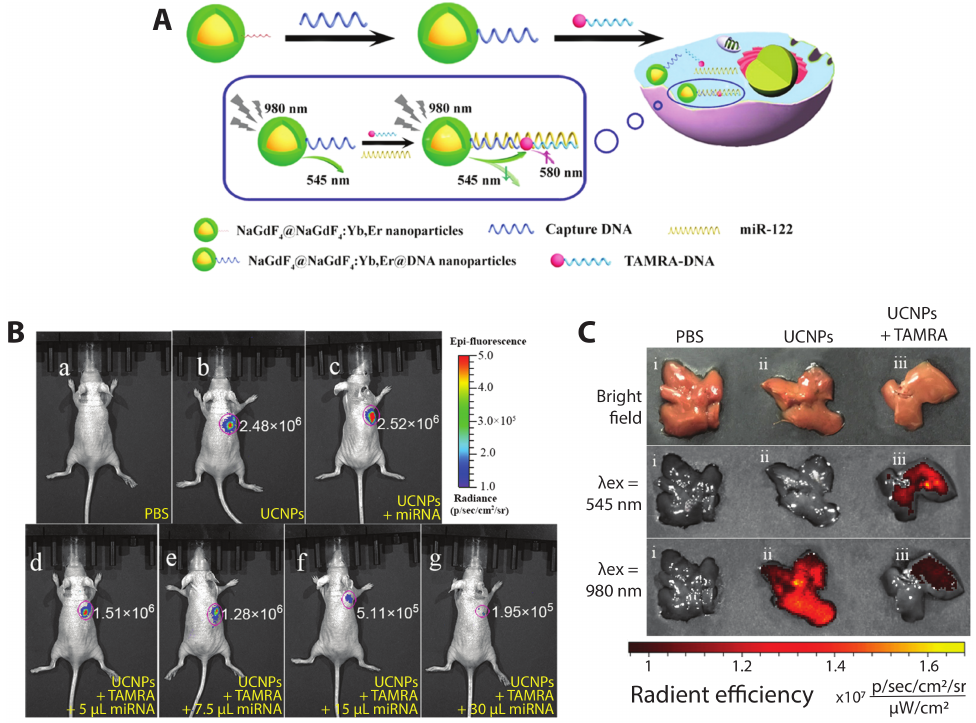
Figure 8. Fluorescence detection of miRNA-122 using a nucleic acid hybridization-based FRET construct with UCNPs. ( A ) Schematic of the hybridization assay. DNA-labeled UCNPs and DNA-labeled TAMRA are brought into close proximity upon binding to distinct complimentary regions of